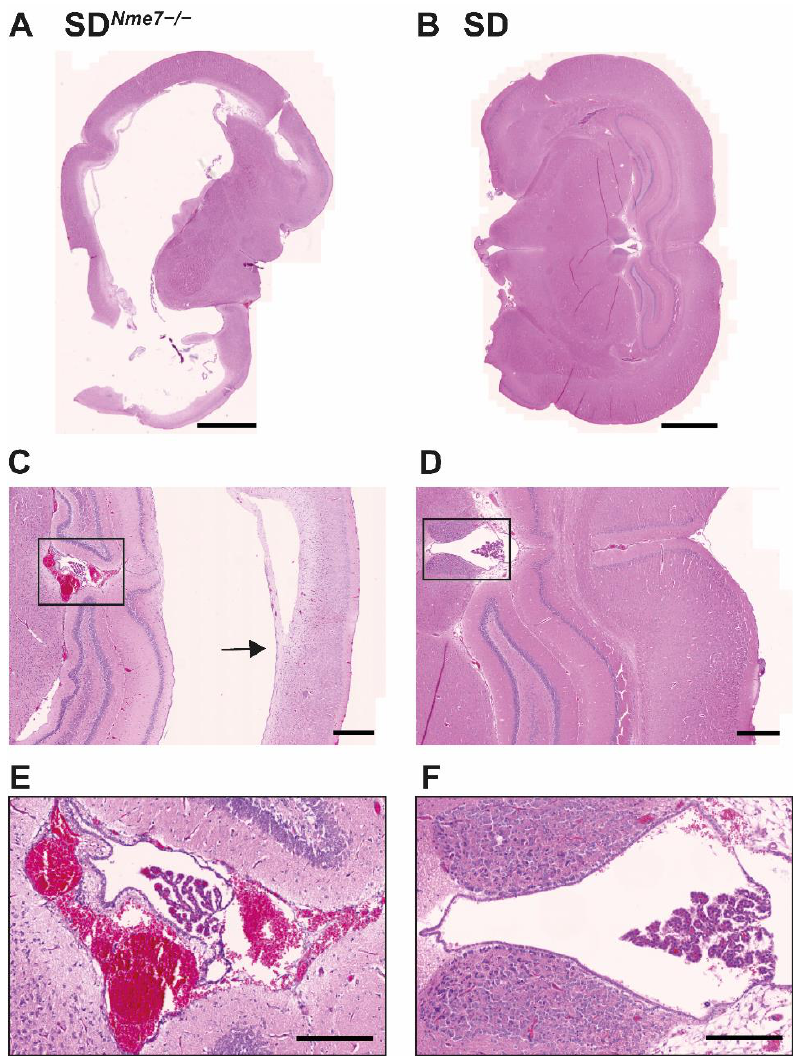
Figure 4. Coronal section of hematoxylin – eosin-stained brain of 6-week old SD Nme7 − / − rat ( A ) show- ing massive hydrocephalus with greatly enlarged lateral ventricles compared to SD littermate ( B ). Detail of deformed hippocampal region with thinning of adjacent cortex (arrow) in the SD Nme7 − / − rat ( C ) compared to the SD counterpart ( D ). Blow-up of the third ventricle with massive bleeding, damaged choroid plexus and ependymal lining in SD Nme7 − / − rat ( E ) contrasting with the standard arrangement of the third ventricle in the SD rat ( F ). The bar indicates 2000 µm for ( A , B ), 500 µm for ( C , D ), 200 µm for ( E , F ).